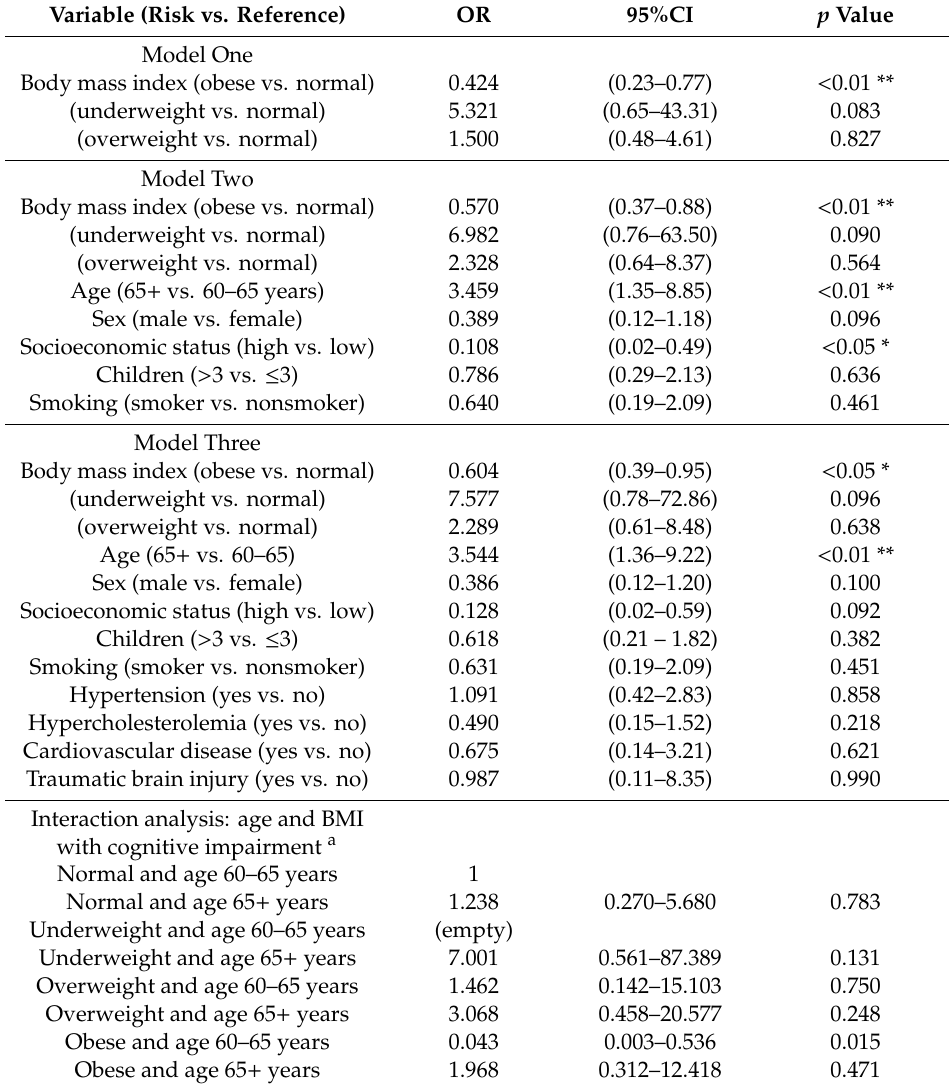
Table 3. Multiple logistic linear analyses of factors associated with cognitive impairment after adjustment for the